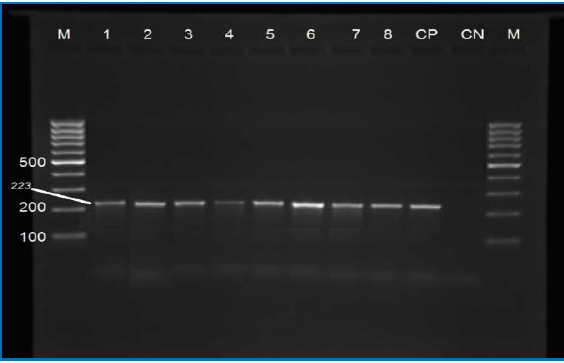
Figure, 2: Electrophoresis on 2 % agarose gel and ethidium bromide staining, showing the results of PCR procedures. M: DNA marker, CP control positive, CN: control negative, wells 1-8 positive samples band in size 223 bp.